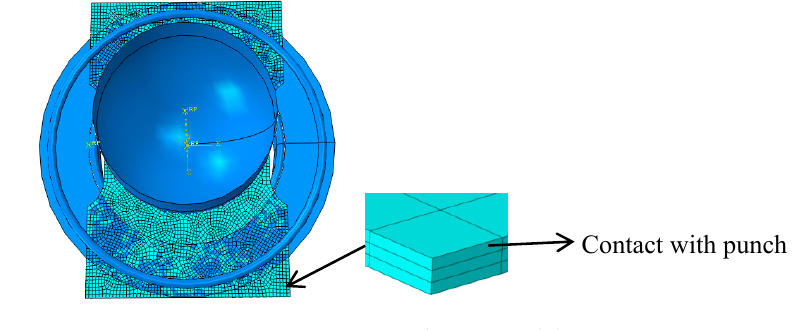
Figure 6. Finite element model. Figure 5. Finite element model.